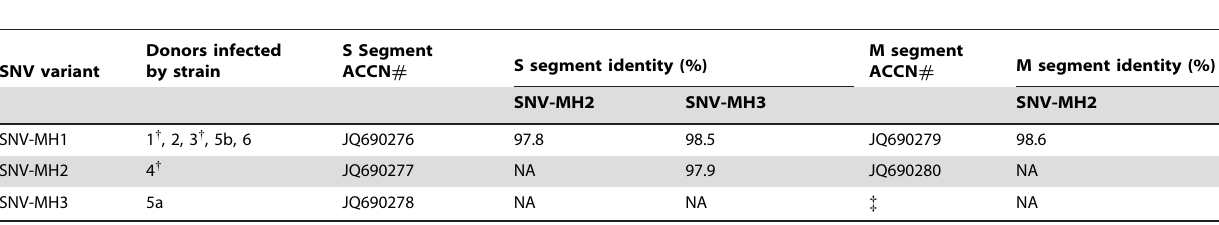
Table 3. Small (S) and medium (M) segment sequence identities at the nucleotide level for SNV variants infecting donors from experiment